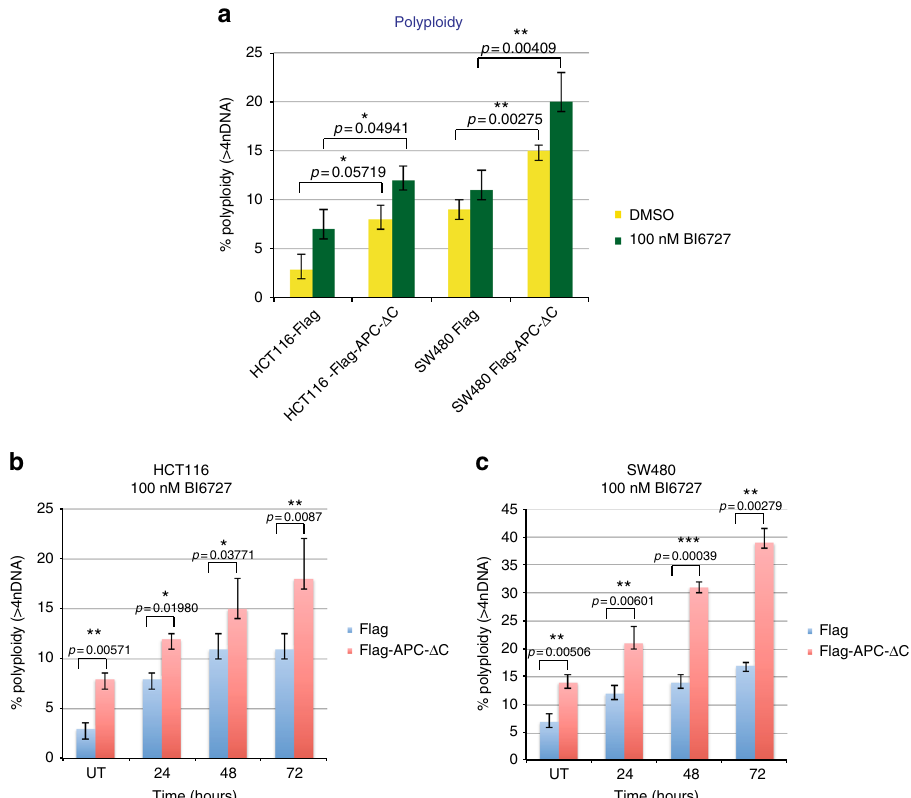
Fig. 3 Chromosomal content of BI6727-treated, APC- Δ C-expressing colon cells. a 300,000 cells (HCT116, SW480) with or without APC- Δ C-expression treated for 24 h with 100 nM BI6727 were then subjected to DAPI staining and examined by FACS for the analysis of the DNA content. b HCT116 and ( c ) SW480 cells with or without APC- Δ C-expression were treated for 24, 48, and 72 h with 100 nM BI6727 and were subsequently subjected to DAPI staining and examination by FACS for the analysis of the DNA content (means ± s.d., n = 3, for each time point). * P < 0.05, ** P < 0.01, *** P < 0.001, Student ’ s t -test, unpaired and